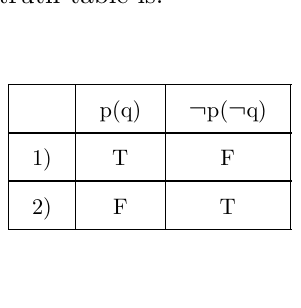
Table 1: Truth-table of negative Graph 1: Truth-graph of negative expression